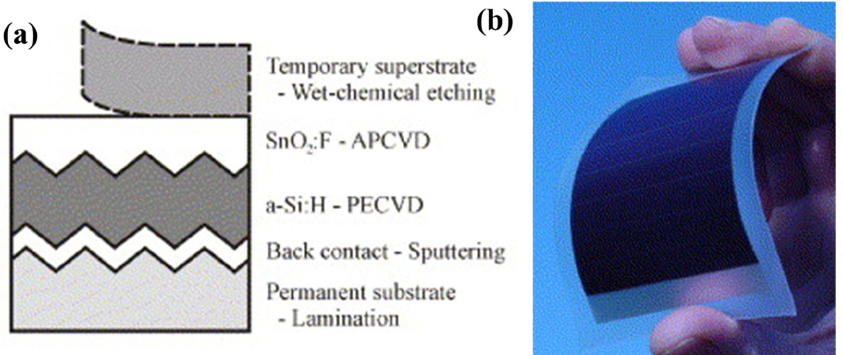
Figure 19. Temporary superstrate concept is shown ( a ) schematically and ( b ) in a photograph. Reprinted with permission from ref. [92]. Copyright 2007 Elsevier.